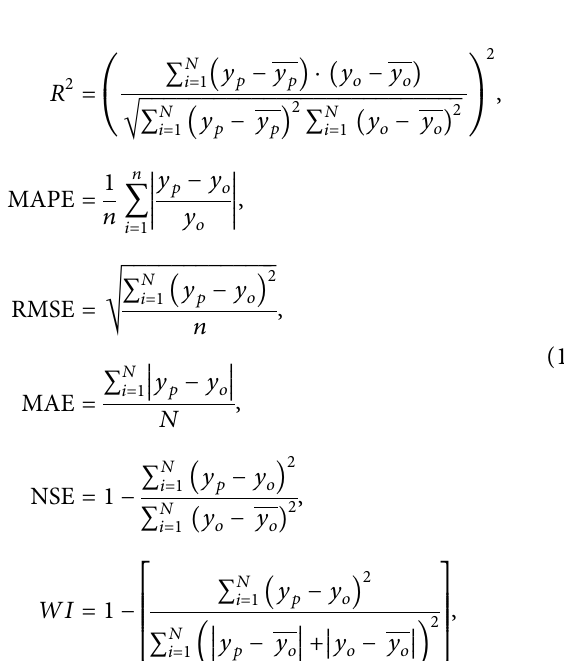
Figure 7: The developed AI models for CS prediction EF